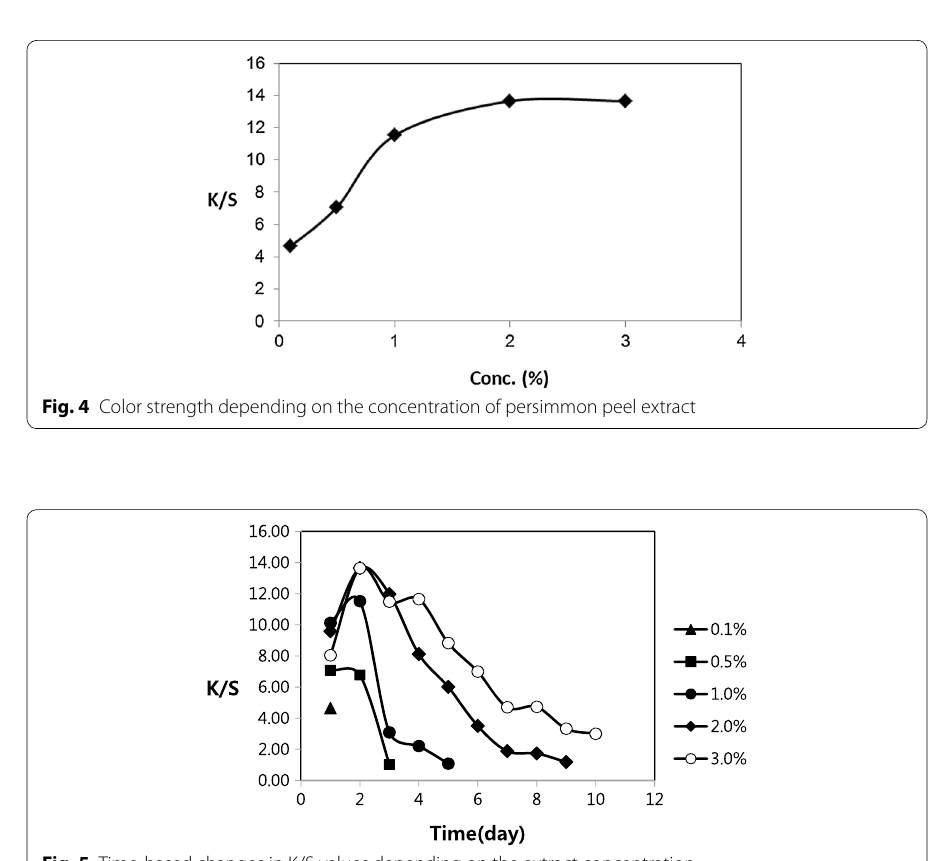
Fig. 5 Time-based changes in K/S values depending on the extract